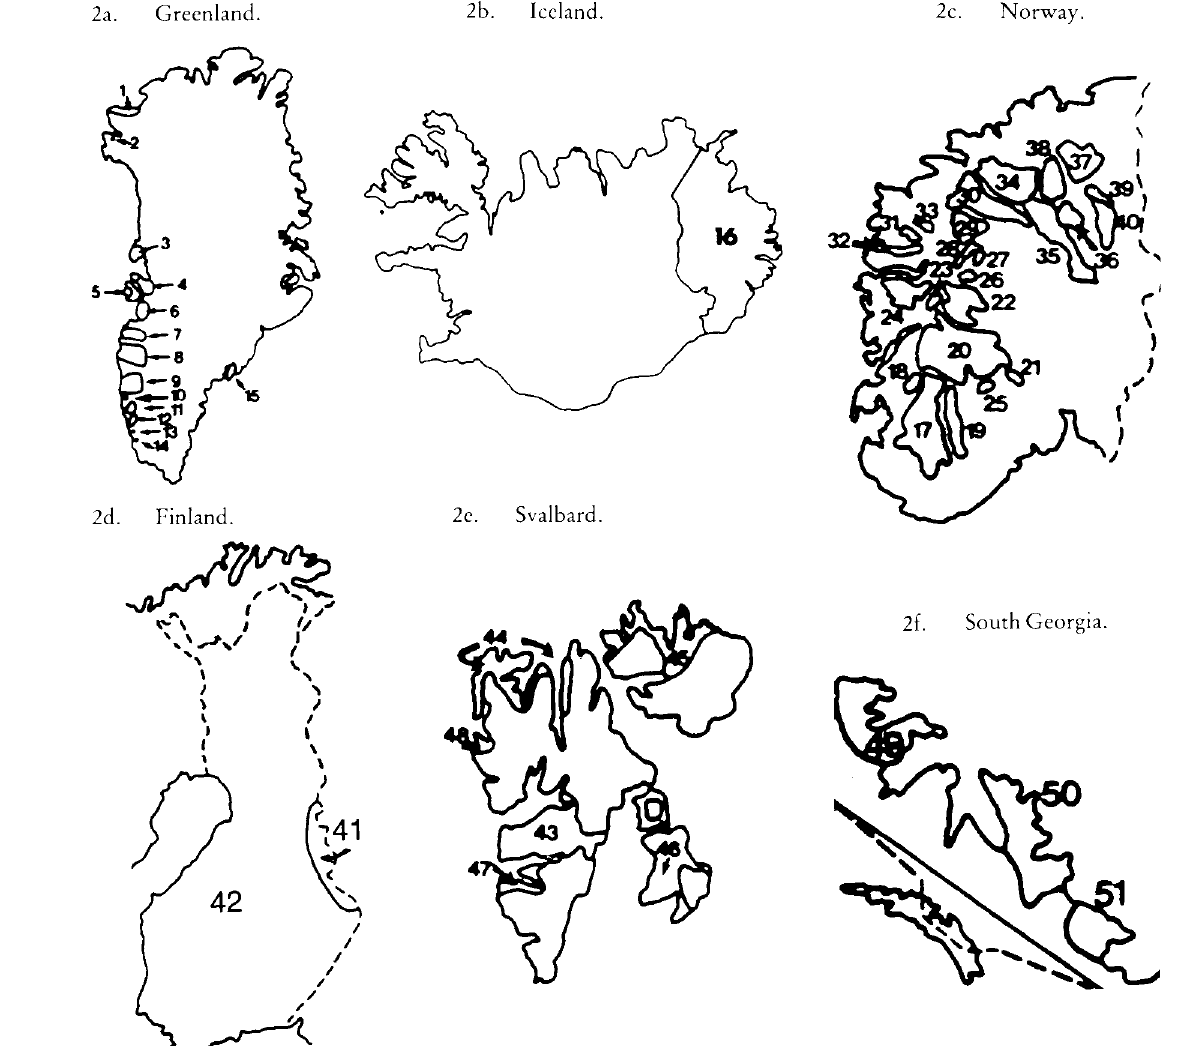
Fig. 2. Wild Rangifcr herd ranges in Europe, Asia and South Georgia. Numbers correspond to Table